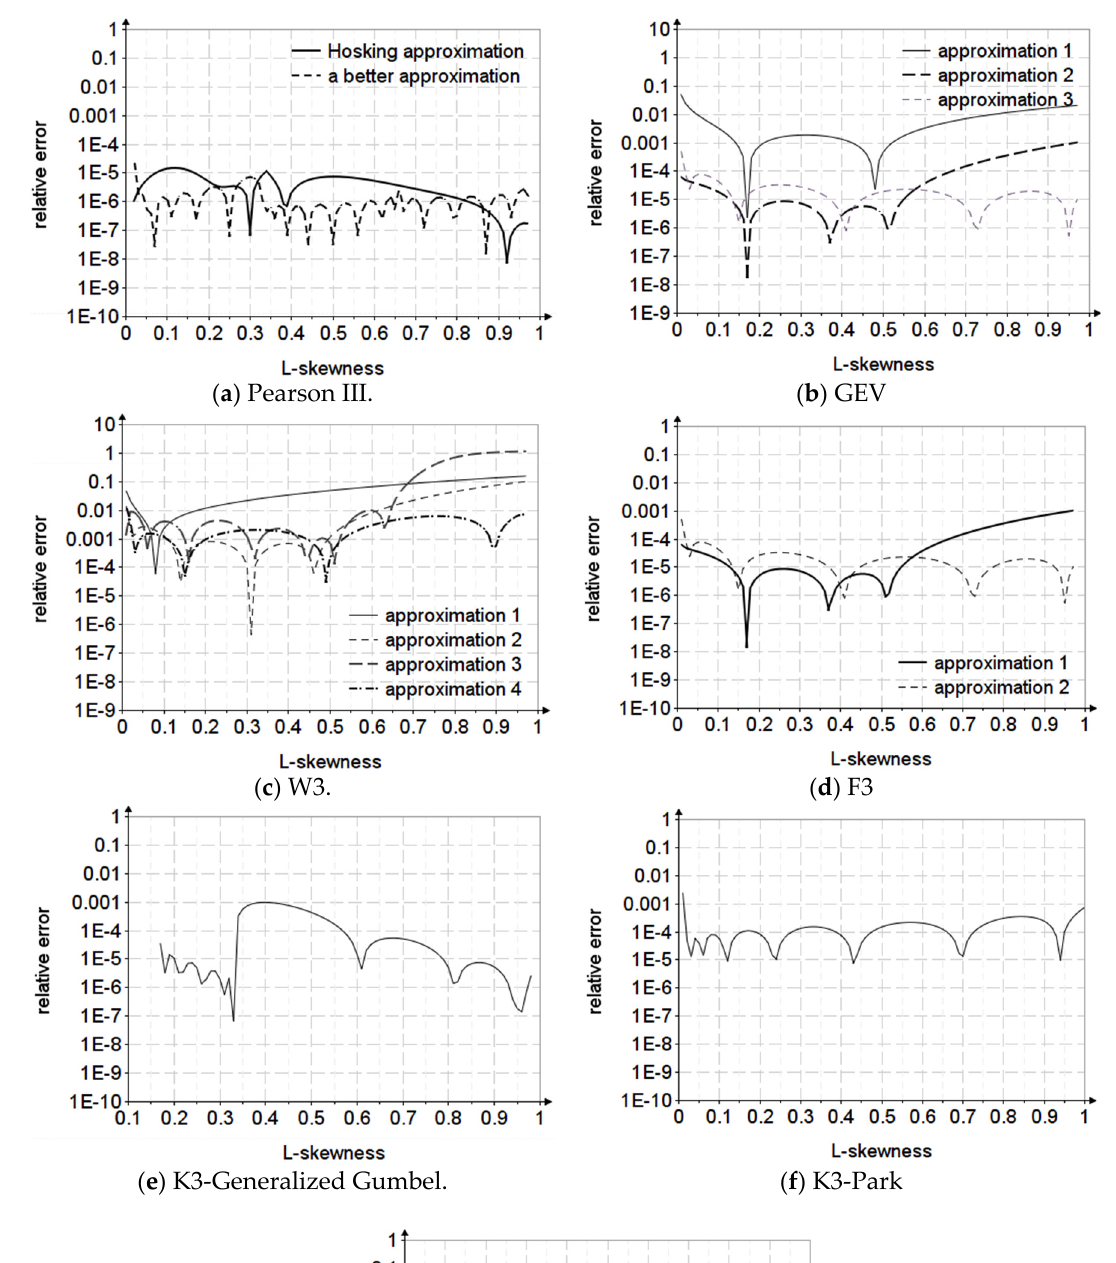
Figure 3. The variation of errors depending on τ